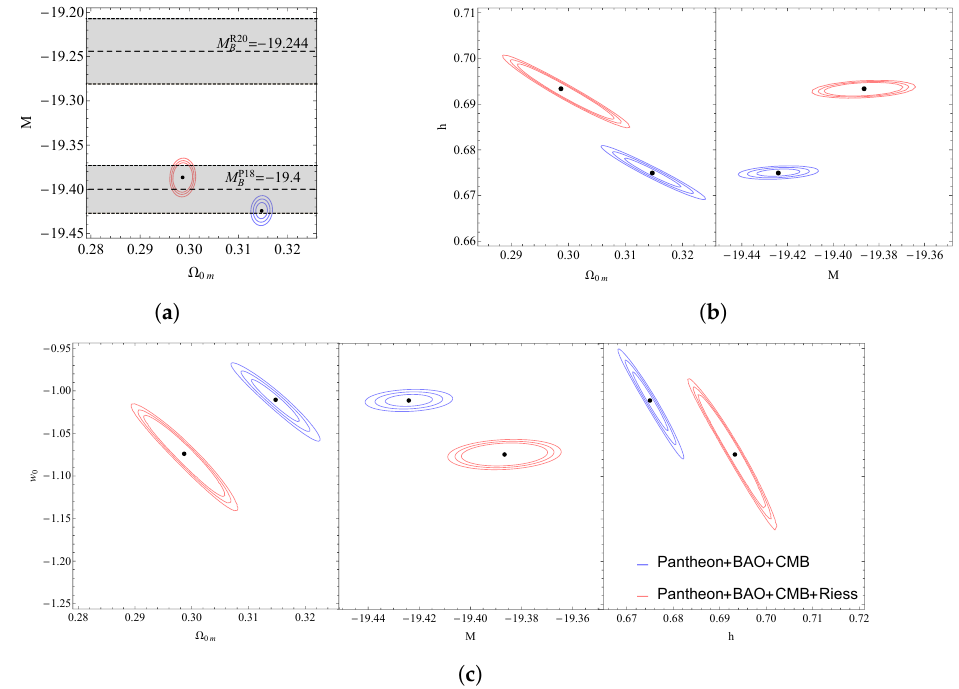
Figure 21. Confidence contours for the wCDM model with the addition of the Riess point: ( a ) The 1 σ − 3 σ confidence contour in the parametric space ( M − Ω 0 m ) . ( b ) The 1 σ − 3 σ confidence con- tours in the parametric spaces ( h − Ω 0 m ) and ( h − M ) . ( c ) The 1 σ − 3 σ confidence contours in the parametric spaces ( w 0 − Ω 0 m ) , ( w 0 − M ) and ( w 0 − h )